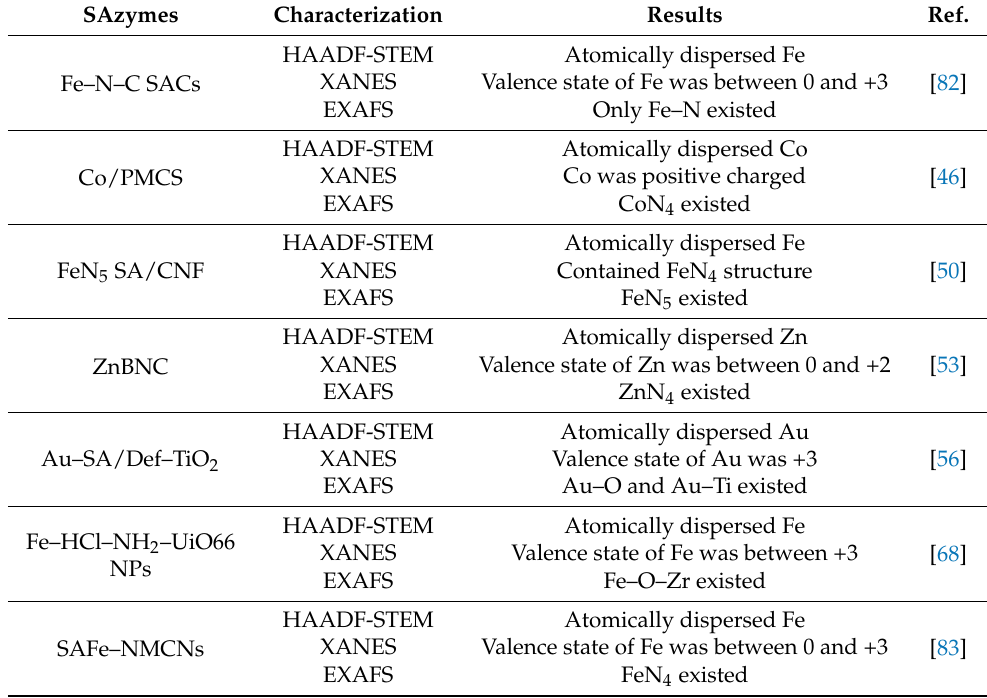
Table 2. Summary of characterizations of